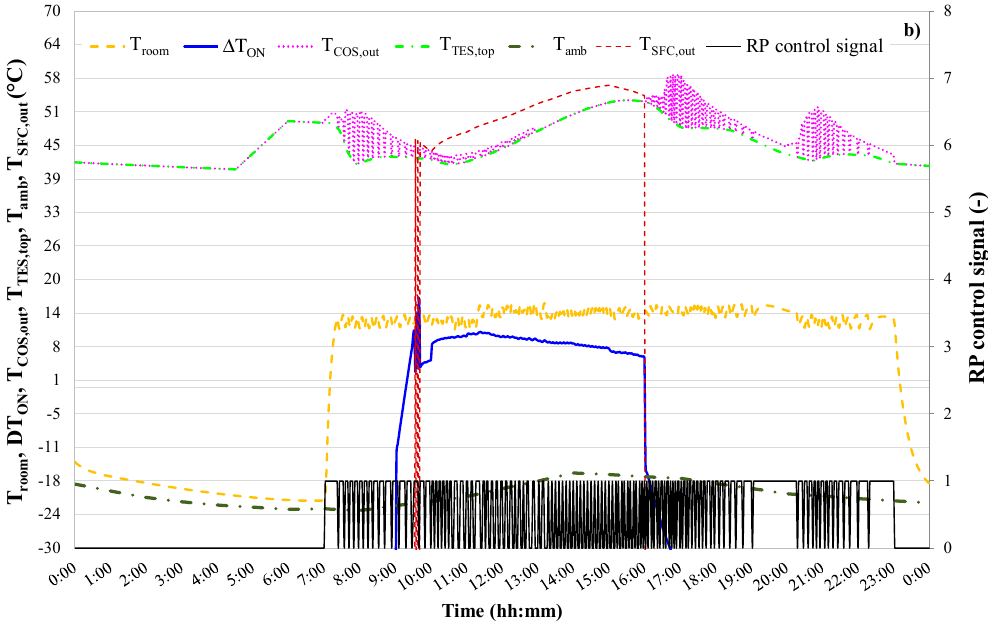
Figure 11. Thermal outputs ( a ) and the radiators circuit pump (RP) control signal together with temperature levels ( b ) associated with the operation of the proposed system during a typical day (Sunday, 1 December).